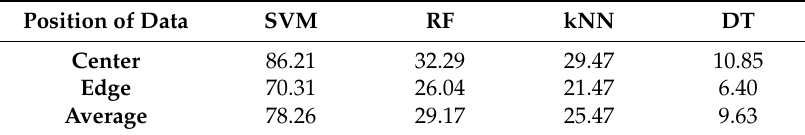
Table 4. CPU time level of improvement after area division